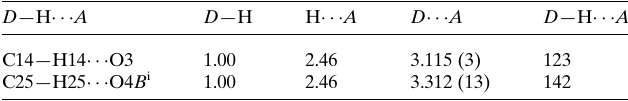
Table 2 Hydrogen-bond geometry (A˚ , (cid:3) ) for ( 8 ).